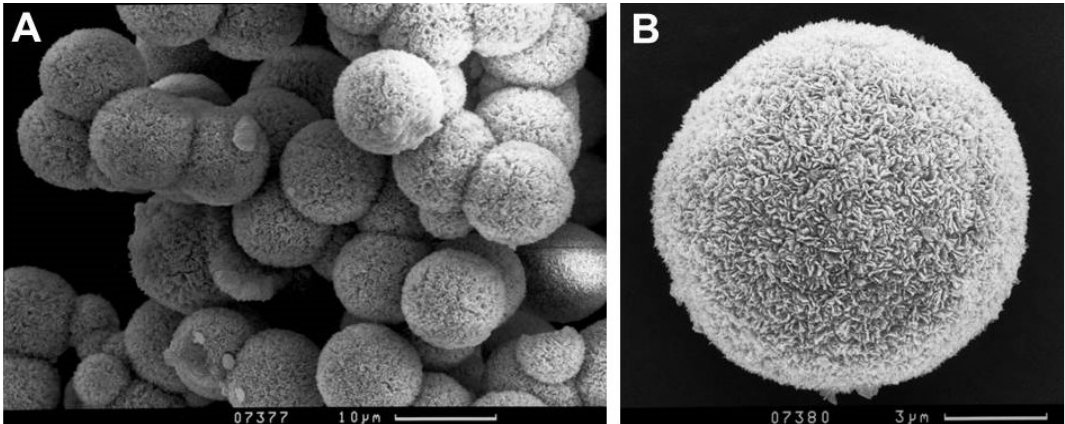
Figure 1. Secondary electron images of representative synthetic analogue of mandarinoite (sample #9; 30 °C, 1.5 bar, 47 days).